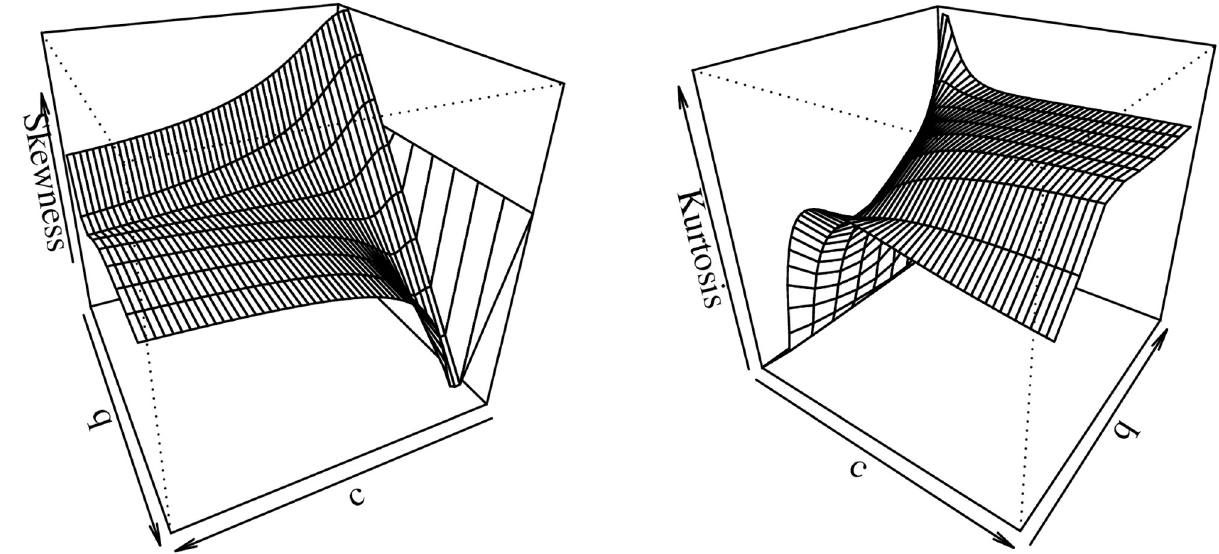
Fig 2. The Bowley skewness and Moors kurtosis of the UBXII